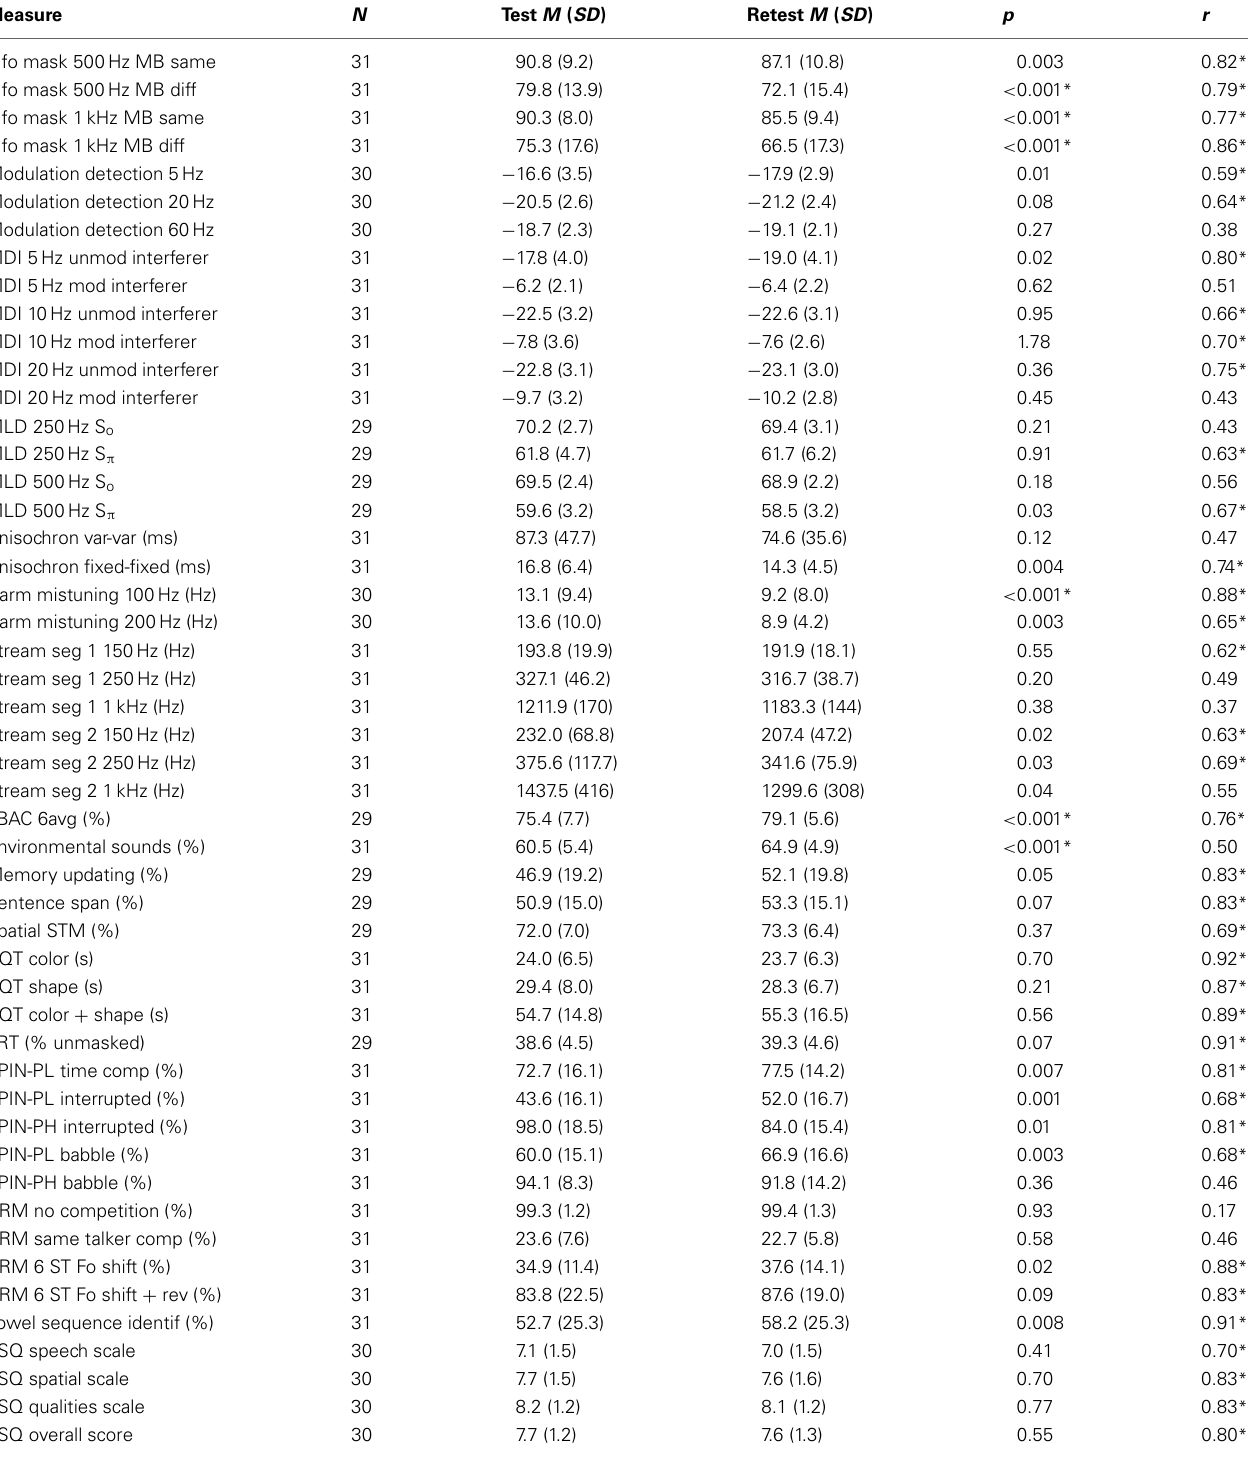
Table 1 | Means (M) and standard deviations (SD) for the test and retest conditions for a group of 31 older adults.